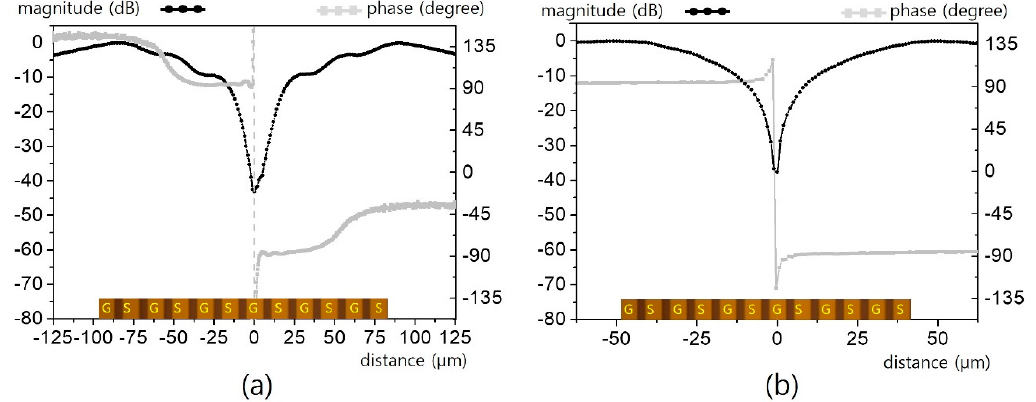
Figure 12. Horizontal electric field distribution for the interdigital lines in Figure 10: ( a ) for a 10 μ m line width, ( b ) for a 5 μ m line width.